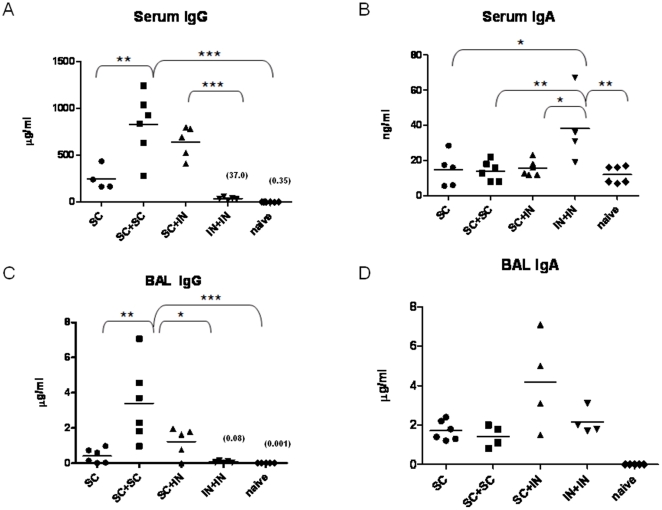
rEF-Tu-specific IgG and IgA concentrations in sera and BAL of immunized mice.Serum IgG (A) and IgA (B) and BAL IgG (C) and IgA (D) were measured by ELISA. SC = subcutaneous immunization with 25 µg rEF-Tu adsorbed 1∶1 with aluminum hydroxide adjuvant. IN = intranasal immunization with 25 µg rEF-Tu admixed with 5 µg CpG adjuvant. Horizontal line represents the median value for each group (N = 6). Median values are provided in parentheses for IN + IN and naïve groups in panels A and C. (*P<0.05, **P<0.01, ***P<0.001 using the Mann-Whitney test).